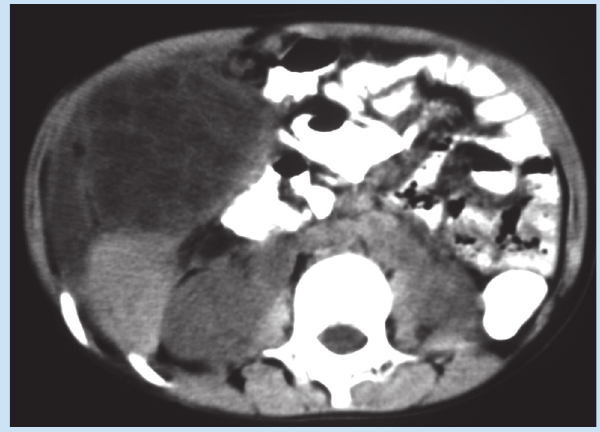
Fig. 2. a. Axial contrasted CT scan demonstrates the hepatic hydatid cyst with internal daughter cysts/brood capsules.